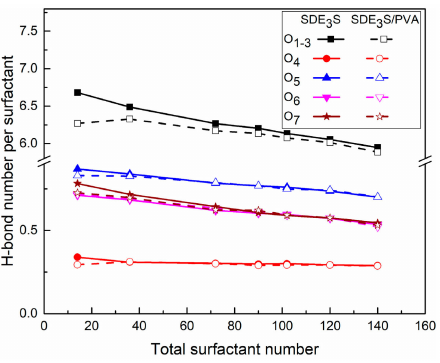
Figure 15. Hydrogen bond numbers per surfactant between di ff erent oxygen atoms in surfactant and water molecules in SDE 3 S and SDE 3 S / PVA